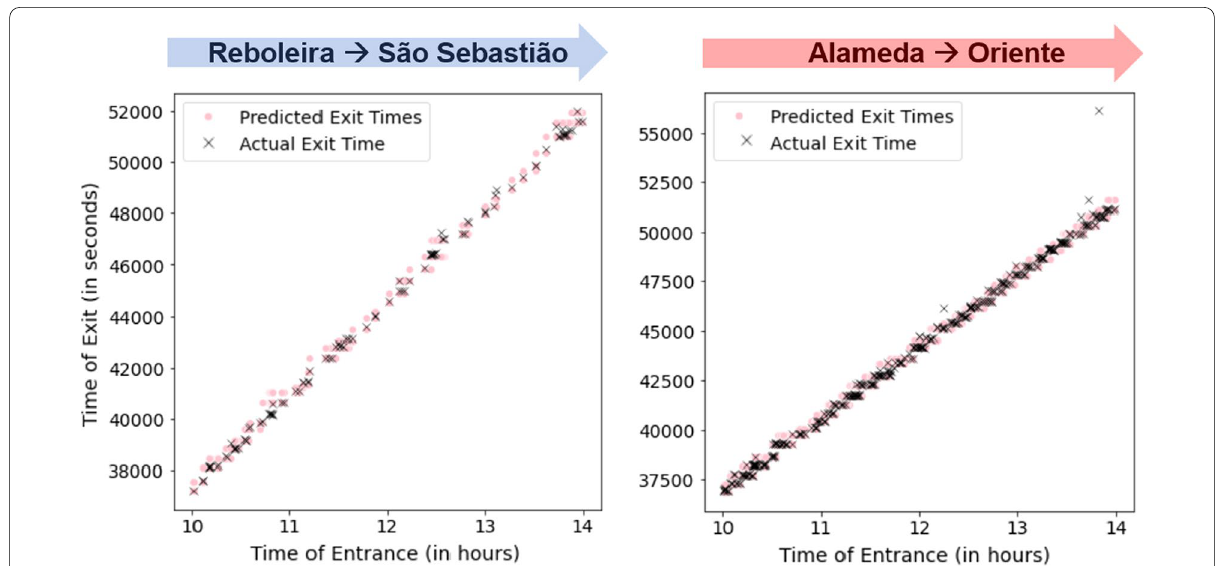
Fig. 10 Examples of two single‑route pairs to validate the prediction of passenger exit